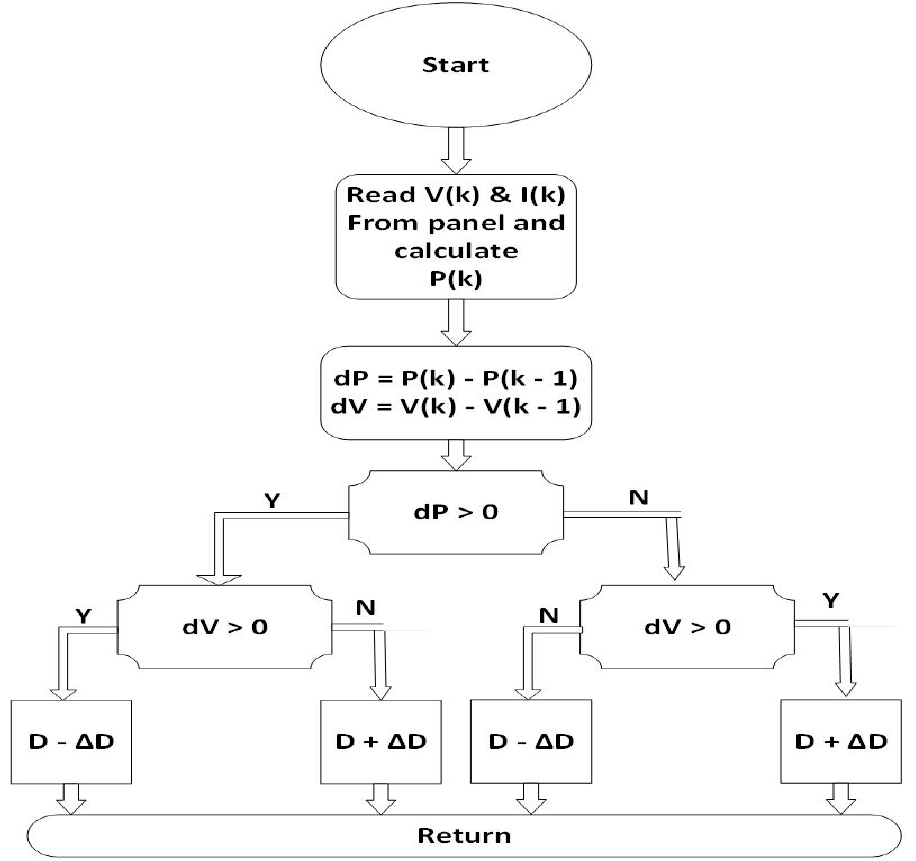
Figure 6. Perturbation and observation method algorithm. Fussy Logic